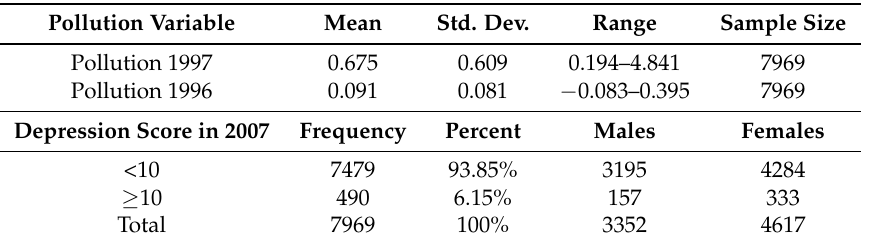
Table 1. Summary